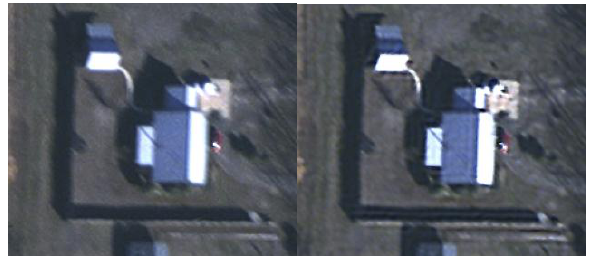
Figure 2 Subsection of an image with 4.1 pixel motion blur (left) and the de-blurred image result (right)